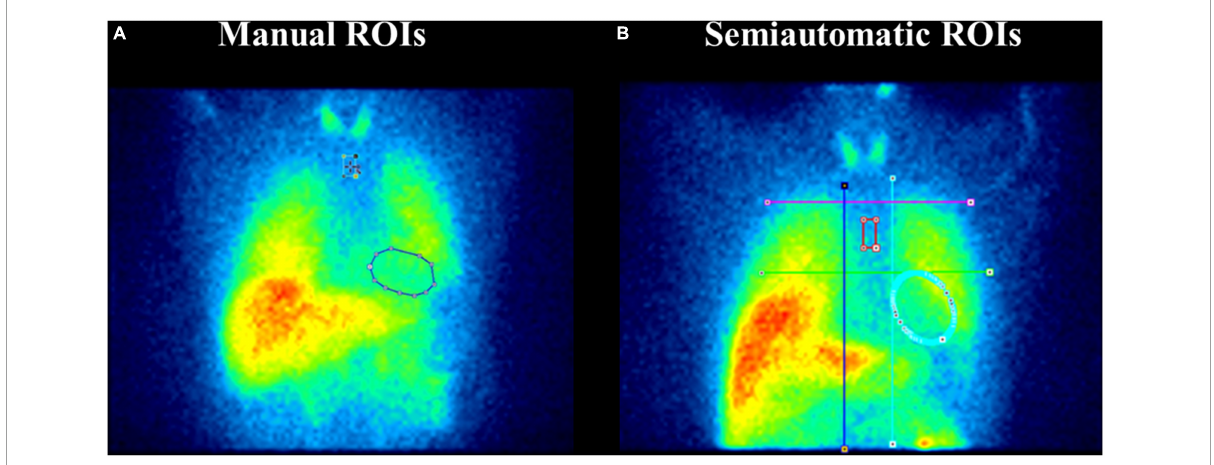
FIGURE1 Manual and fixed-size regions of interest (ROIs) on planar 123 I-metaiodobenzylguanidine (MIBG) images. Panel (A) depicts the manual ROIs method. A rectangular mediastinal ROI is used with unspecified size and located on planar MIBG images below the thyroid. The manual-drawn cardiac ROI is polygonal and includes the myocardium and the left ventricular cavity. Panel (B) represents the semi-automatic ROIs method. An “anatomical landmark square” is formed by the lung apexes (upper square border), the upper cardiac border (lower square border), and the medial contours of the lungs (medial square borders) to place fixed-size mediastinum and oval cardiac ROIs. Precisely, a fixed-size rectangular mediastinal ROI (13 × 20 pixel) and an oval cardiac ROI are placed on MIBG planar images. The mediastinal ROI is placed in the half of the “anatomical landmark square” formed by lungs apexes, the upper cardiac border, and the medial contours of the lung. The cardiac oval ROI (60 × 70 pixel) is placed in the lower-right quadrant, over the myocardium, including the left ventricular